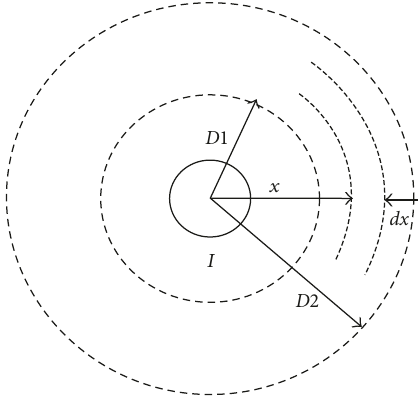
Figure 4: Concentric magnetic field of the external magnetic flux